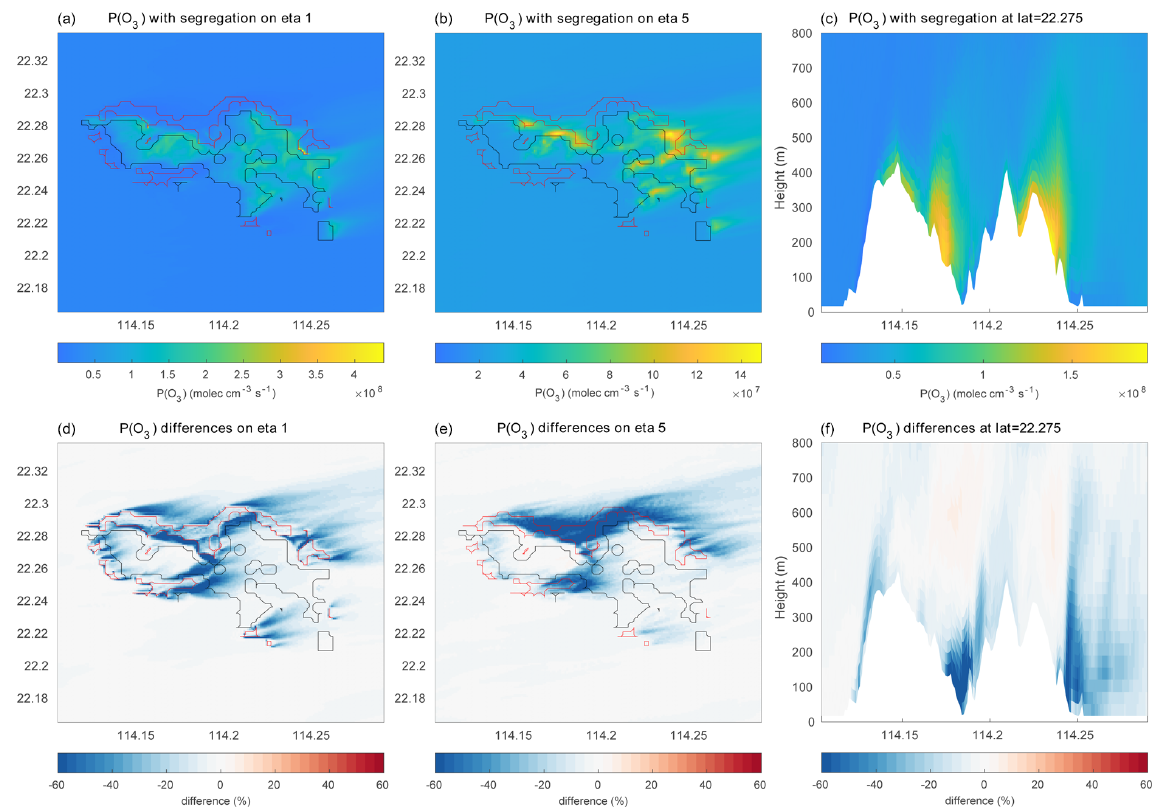
Figure 15. (a–c) Production rate of ozone (molec.cm − 3 s − 1 ) in and around Hong Kong Island. (a) Values at the lowest model level, (b) values at model level 5, and (c) values as a function of height along the constant latitude of 22.275 ◦ N. (d–f) Same but for the percentage difference between ozone production rates with and without segregation effects taken into